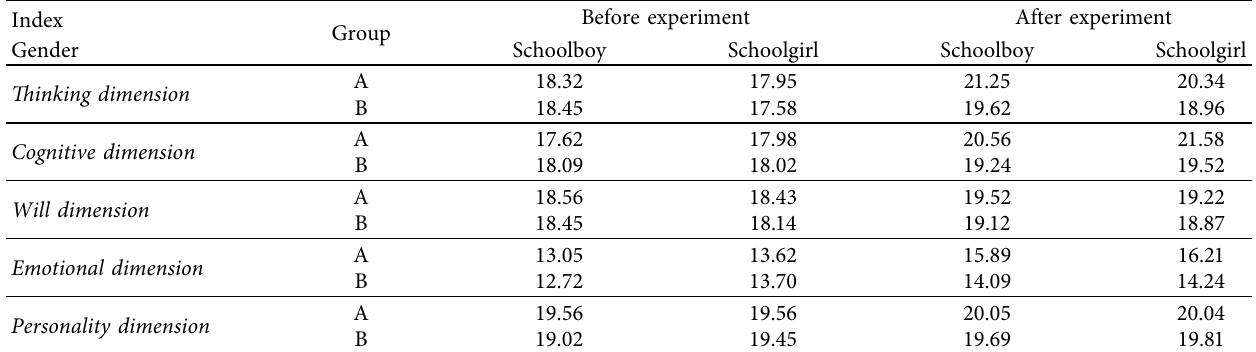
Table 6: Psychological impact of Wushu and aerobics on